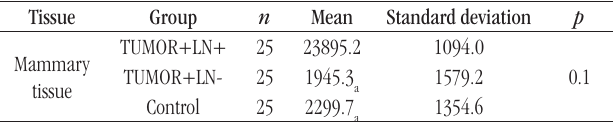
taBLE 3 − Results of the quantitative data analysis of the Ki-67 expression in the mammary tissue among the different groups studied (values in µm 2 ) Tissue taBLE 1 − Absolute and relative distribution of anti-Hsp27 antibody positivity for the three groups considering the number of cases where presence or absence (zero) of expression was detected ( n = 75) Tumor Lymph node Group Total Cases % Cases TUMOR+LN+ Expression detected 84% 100% taBLE 4 − Results of the quantitative data analysis of the caspase 3 Expression not detected 0% expression in the mammary tissue among the different TUMOR+LN- 25 groups studied (values in µm 2 Expression detected 25 Expression not detected